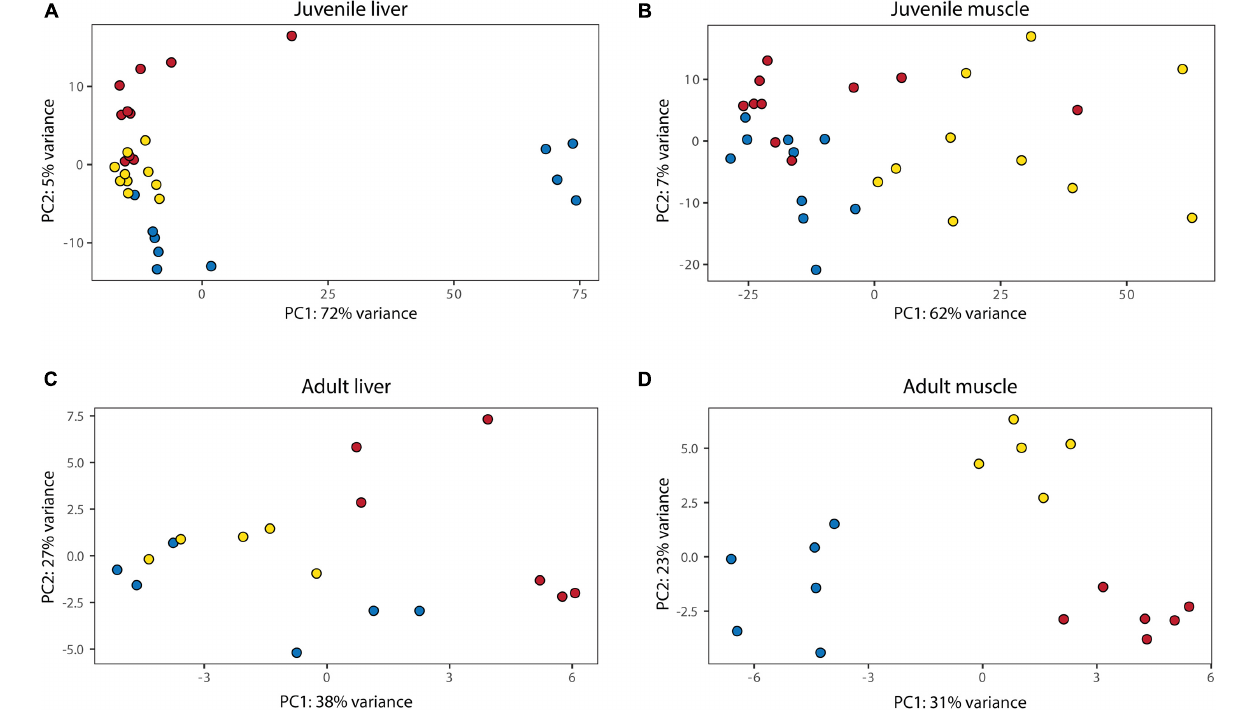
FIGURE 4 | Principal component analysis (PCA) of variance-stabilized gene expression data for significantly differentially expressed genes (likelihood ratio test, p - adj < 0.05) in (A) juvenile liver, (B) juvenile muscle, (C) adult liver, and (D) adult muscle tissue. Samples in the control treatment are shown in blue, those in the +3 ◦ C treatment are shown in yellow, and individuals in the +6 ◦ C treatment are shown in